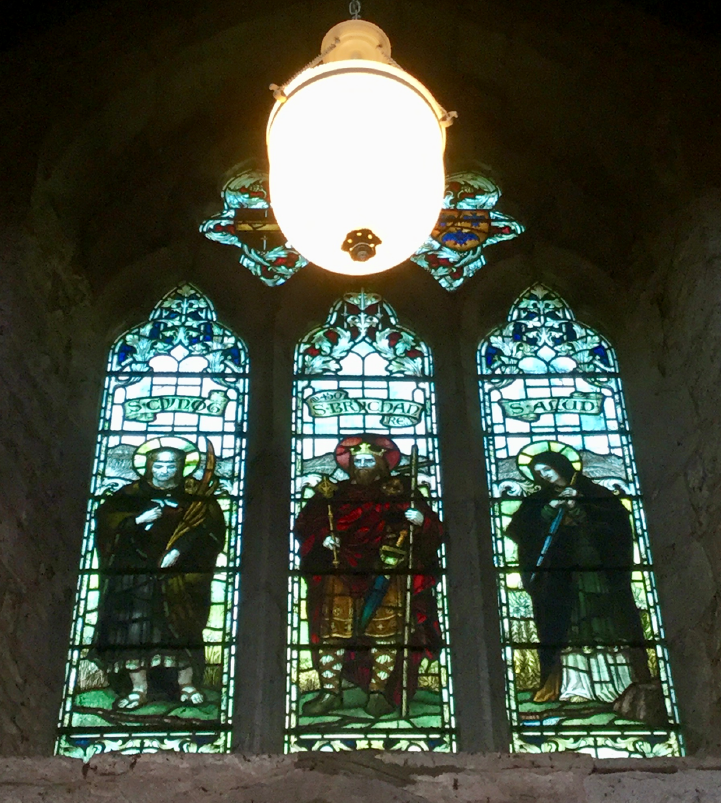
Figure 4. Stainglass window in the Cordwainers chapel, in Brecon Cathedral. Depicting to the right St. Eluned, in the middle, her father Brychan and to the left, her brother, Cynog. Image taken by author during a visit in 2019.